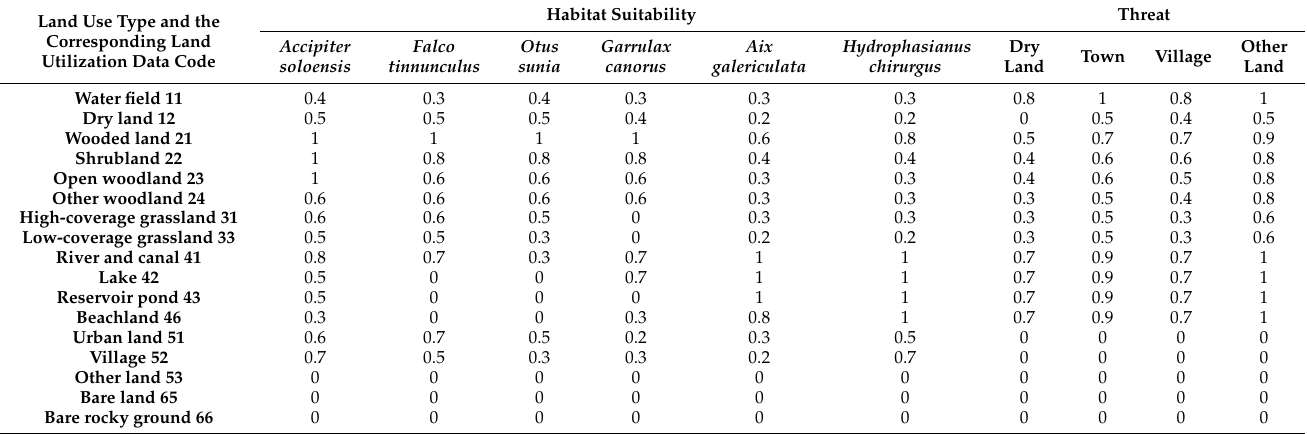
Table 3. Habitat connectivity and sensitivity of various land use to threat sources for target